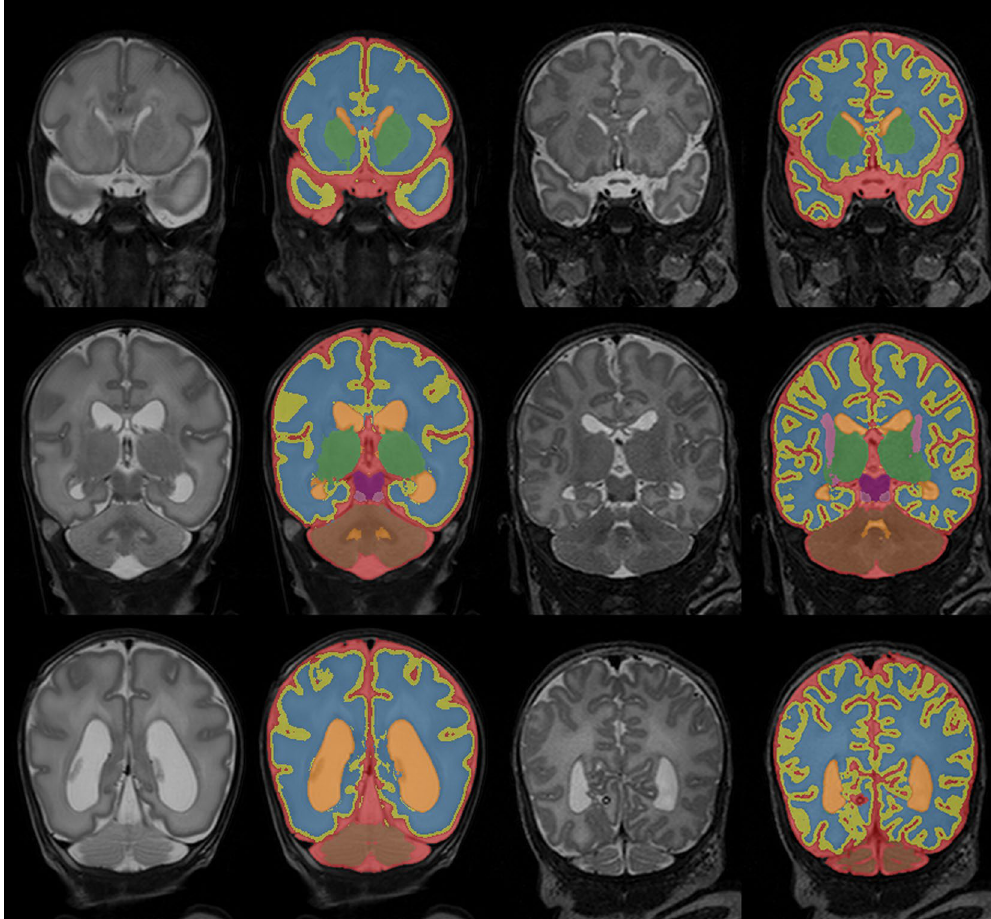
Figure 2. Automatic segmentation of the extracerebral cerebrospinal fluid (red), cortical grey matter (yellow), unmyelinated white matter (blue), ventricular cerebrospinal fluid (orange), basal ganglia and thalami (green), brain stem (purple), myelinated white matter (pink), and cerebellum (brown) in three slices of the images acquired at 30 (left) and 40 (right) weeks PMA for one patient. The images are scaled and cropped separately for better visualisation and do therefore not represent differences in size between 30 and 40 weeks